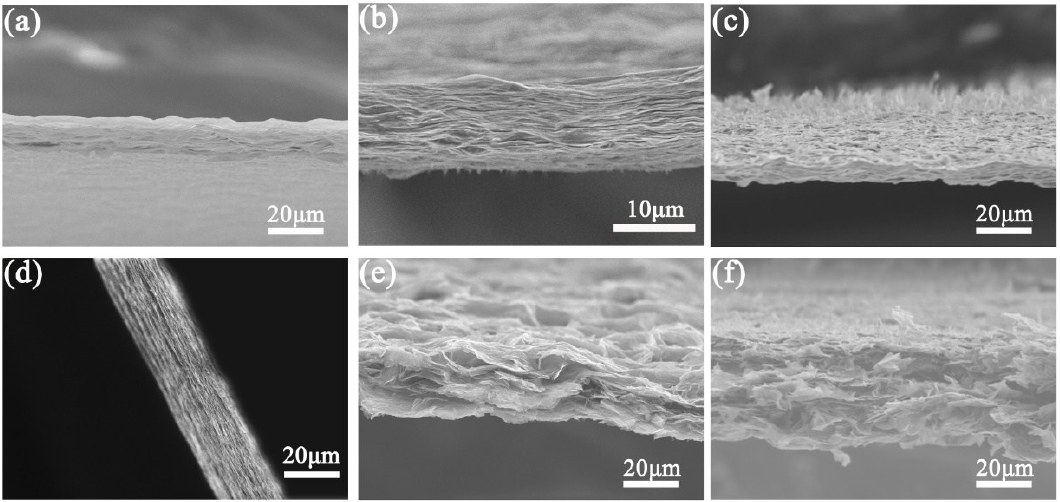
Figure 1. SEM cross-sectional images of ( a ) graphene oxide (GO)-h; ( b ) GO-f; ( c ) GO-LN; ( d ) chemically reduced graphene oxide (CRGO)-h; ( e ) CRGO-f; and ( f ) CRGO-LN.